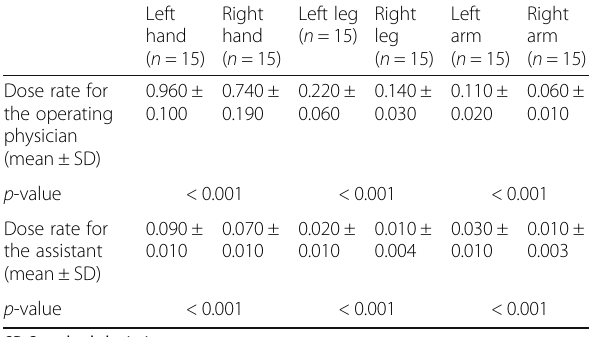
Table 1 Radiation dose rate (mSv/h) for the operating physician and the assistant